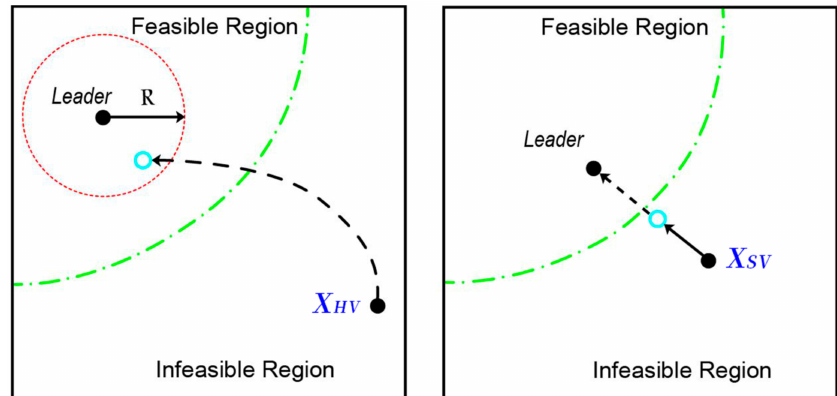
Figure 3. The moving strategies of X HV and X SV .